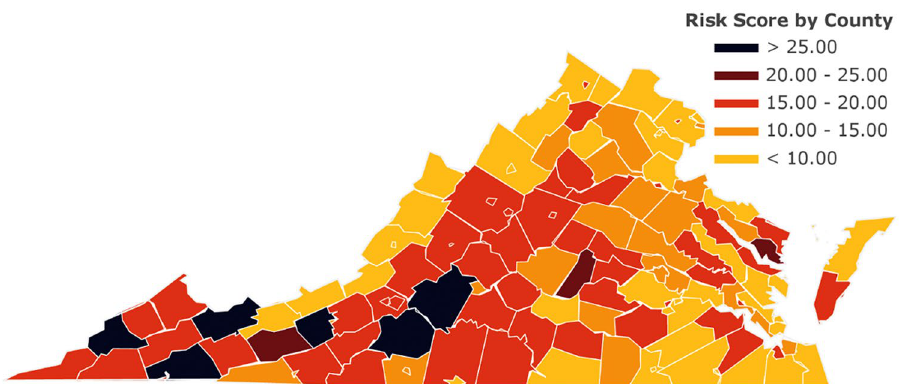
Figure 8. Aggregated risk scores for individual counties in